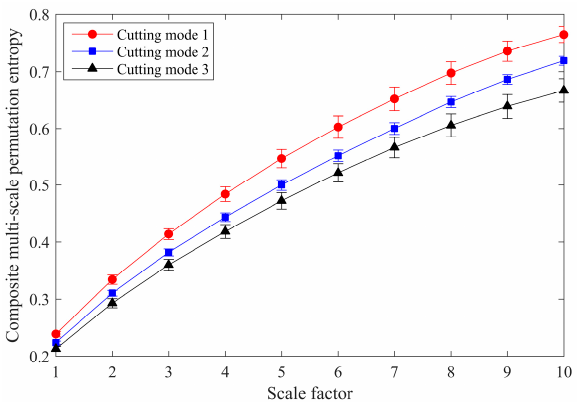
Figure 7. The mean value and standard deviation curve of composite multi-scale permutation en- tropy.